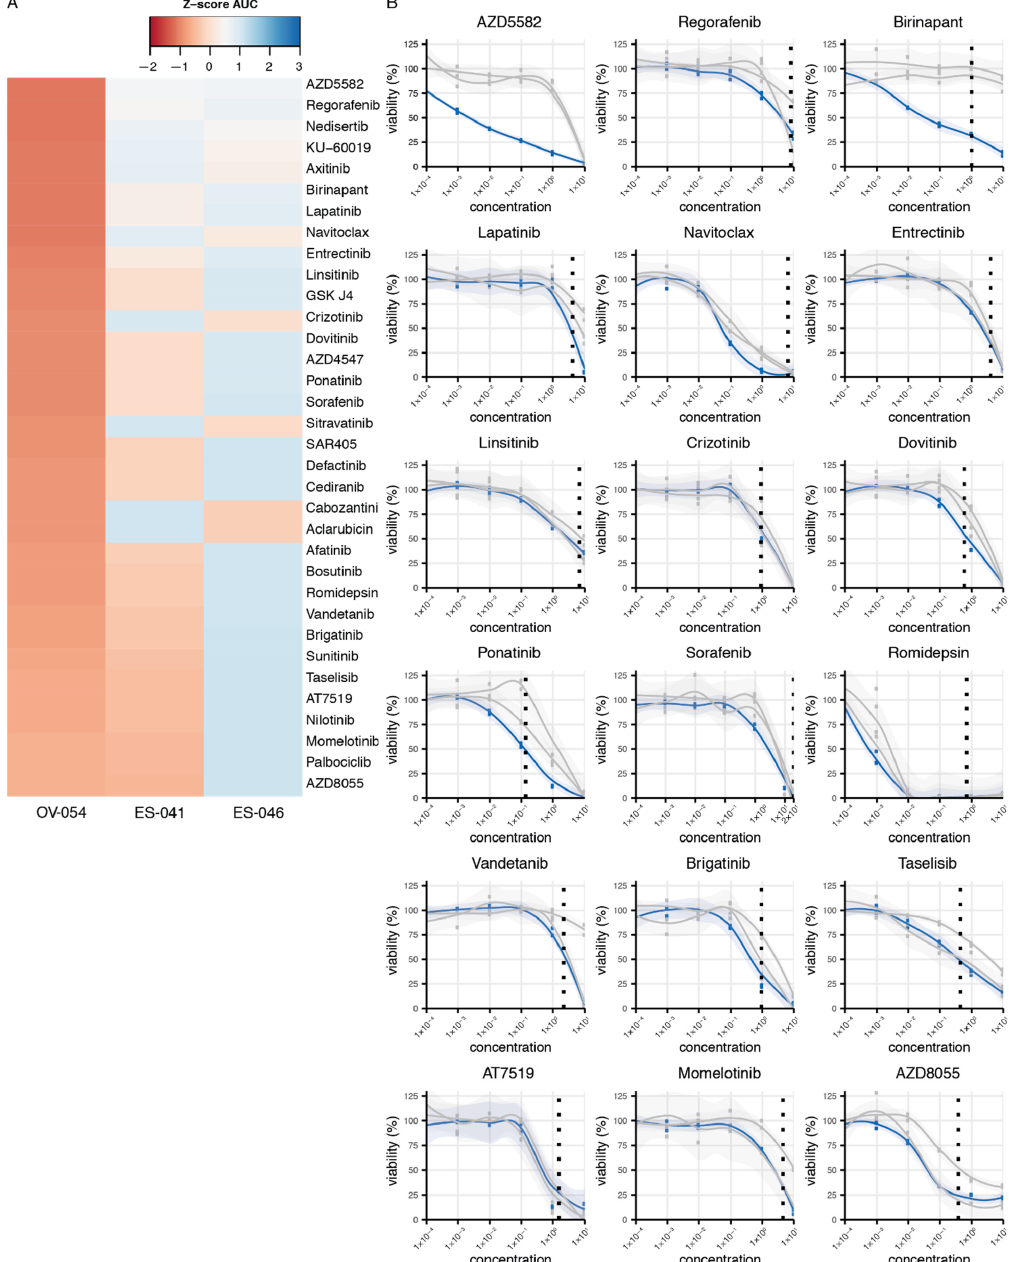
Figure 6. Compound screen on OV-054 DSRCT cells reveals compounds that affect cell viability. ( A ) Heatmap depicting the most sensitive compounds for OV-054 DSRCT, compared to two Ewing sarcoma models (ES-041 and ES-046); colors represent AUC Z-scores. ( B ) Graphs depicting cell viability of OV-054 DSRCT (blue) and the two Ewing sarcoma models (gray), upon a 5-day incubation with different drug concentrations (µM). Known plasma concentrations are shown with the vertical dashed line [23–33].